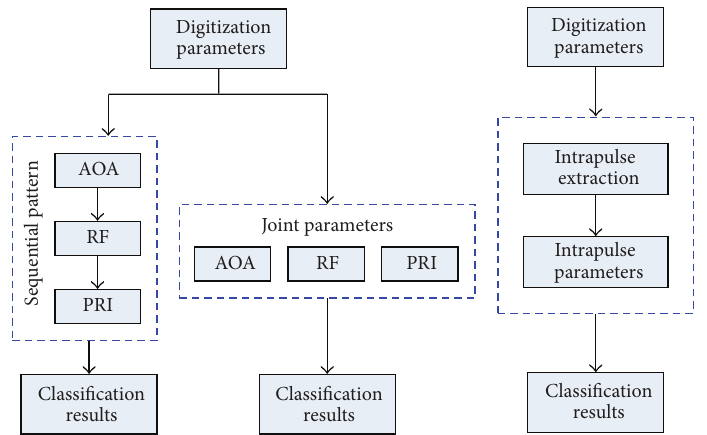
Figure 2: Two handling methods used in radar emitter